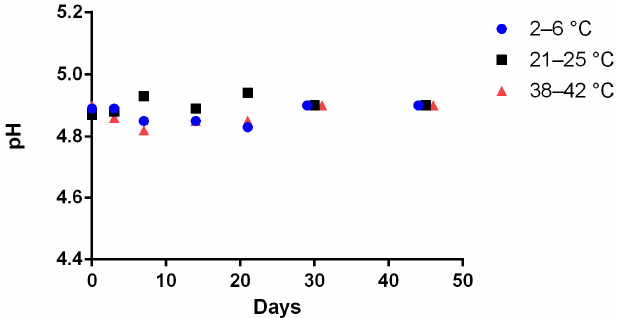
Figure 6. pH value of the reconstituted Methionine 200 mg/mL formulated suspension stored at 4 ± 2 °C (blue circle), 23 ± 2 °C (black square), 40 ± 2 °C (red triangle) in glass pharmaceutical bottles and over time (for more visibility the points have been shifted for days 30 and days 45; standard deviation bars are not visible on the figure due to low data scatter; n =3).